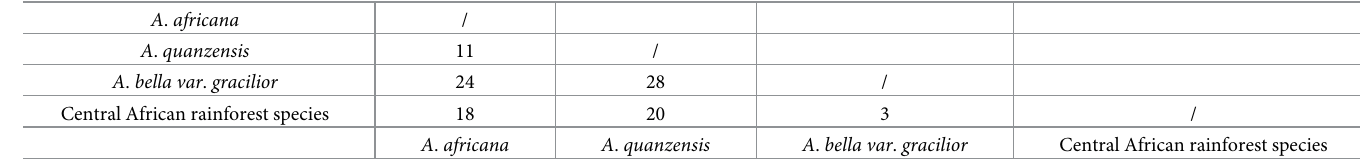
Table 4. SNP variation in the ETS region among Afzelia species. “Central African rainforest species” indicates A . bella var . bella , A . bipindensis and A . pachyloba .